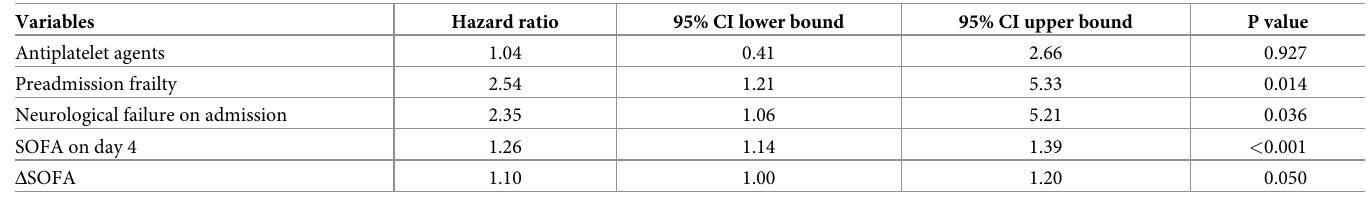
SOFA, sequential organ failure assessment; CI, confidence interval.